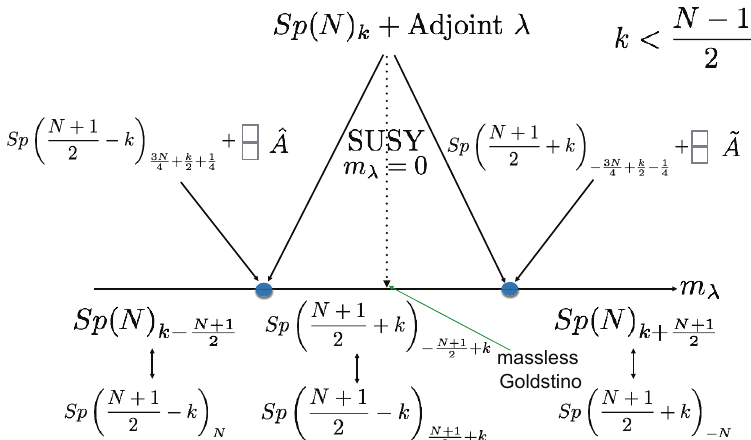
Figure 16: The phase diagram for Sp ( N ) gauge theory with an adjoint fermion k for k < ( N − 1 ) / 2. There are two phase transitions between different infrared TQFTs. There is also a massless Goldstino at the supersymmetric point. We propose a dual fermionic description of the two